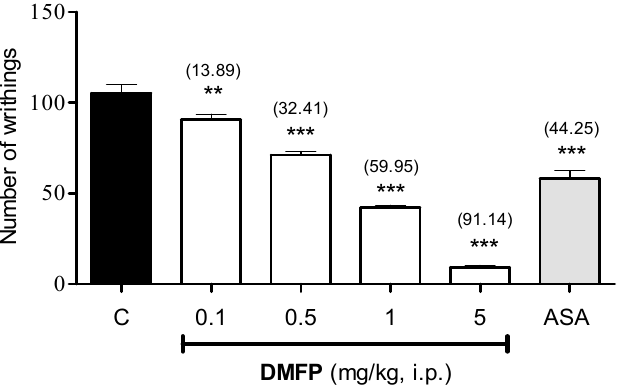
Figure 2. Effect of DMFP (0.1, 0.5, 1 and 5 mg/kg, i.p.) in acetic acid-induced abdominal-writhing test in mice. Each column represents the mean ± S.E.M. ( n = 6). The mice were pretreated with vehicle (C, 10 mL/kg, i.p.), DMFP (0.1, 0.5, 1.0 and 5.0 mg/kg, i.p.) or acetylsalicylic acid (ASA, 100 mg/kg, i.p.). The asterisks denote significance levels ** p < 0.01, *** p < 0.001, when compared with the control